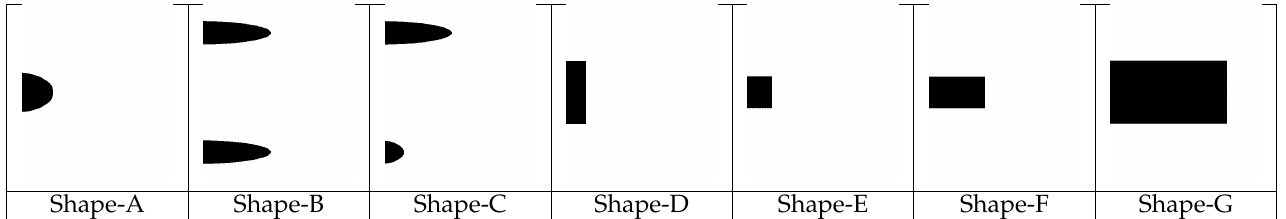
Figure 3. Selection of shape deposition “representative” of potential deposition in the shell side of the boiling tubes in a steam